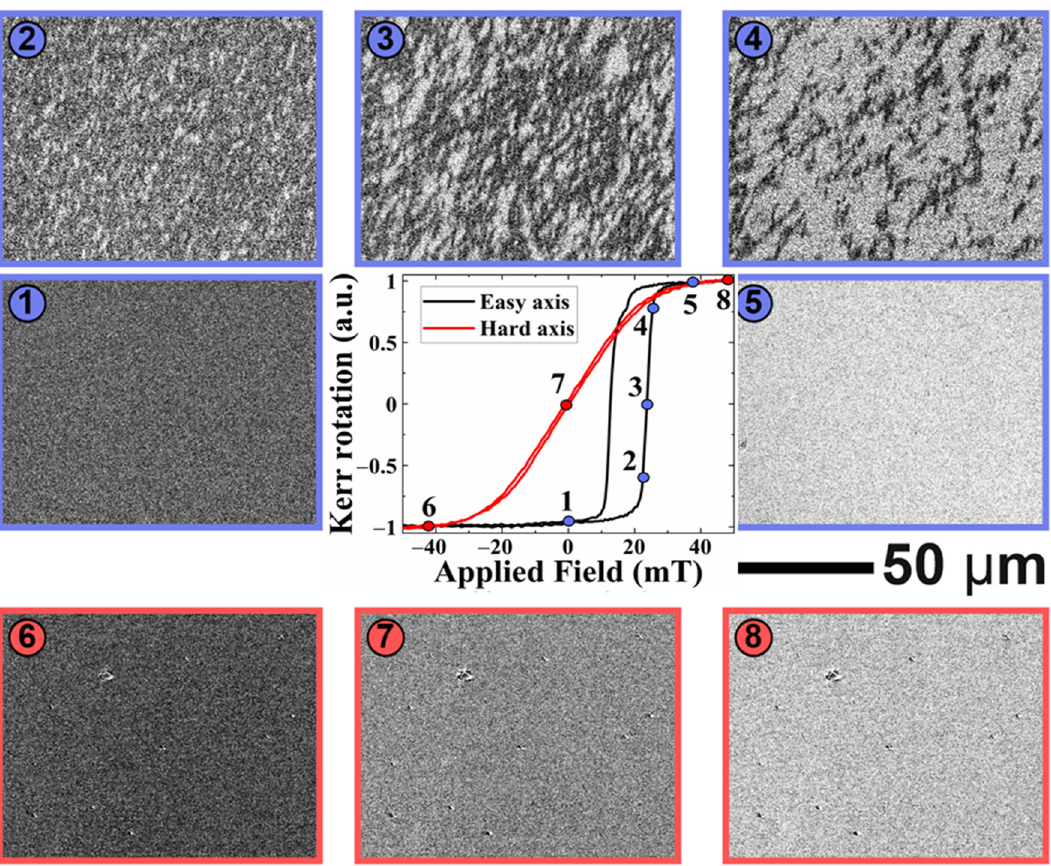
Figure 8. Magnetization reversal loop and magnetic domain evolution in bi-layer structure, measured by Kerr magnetometry with the external magnetic field applied along easy axis μ 0 H x (black curve) and along hard axis μ 0 H y (red curve).